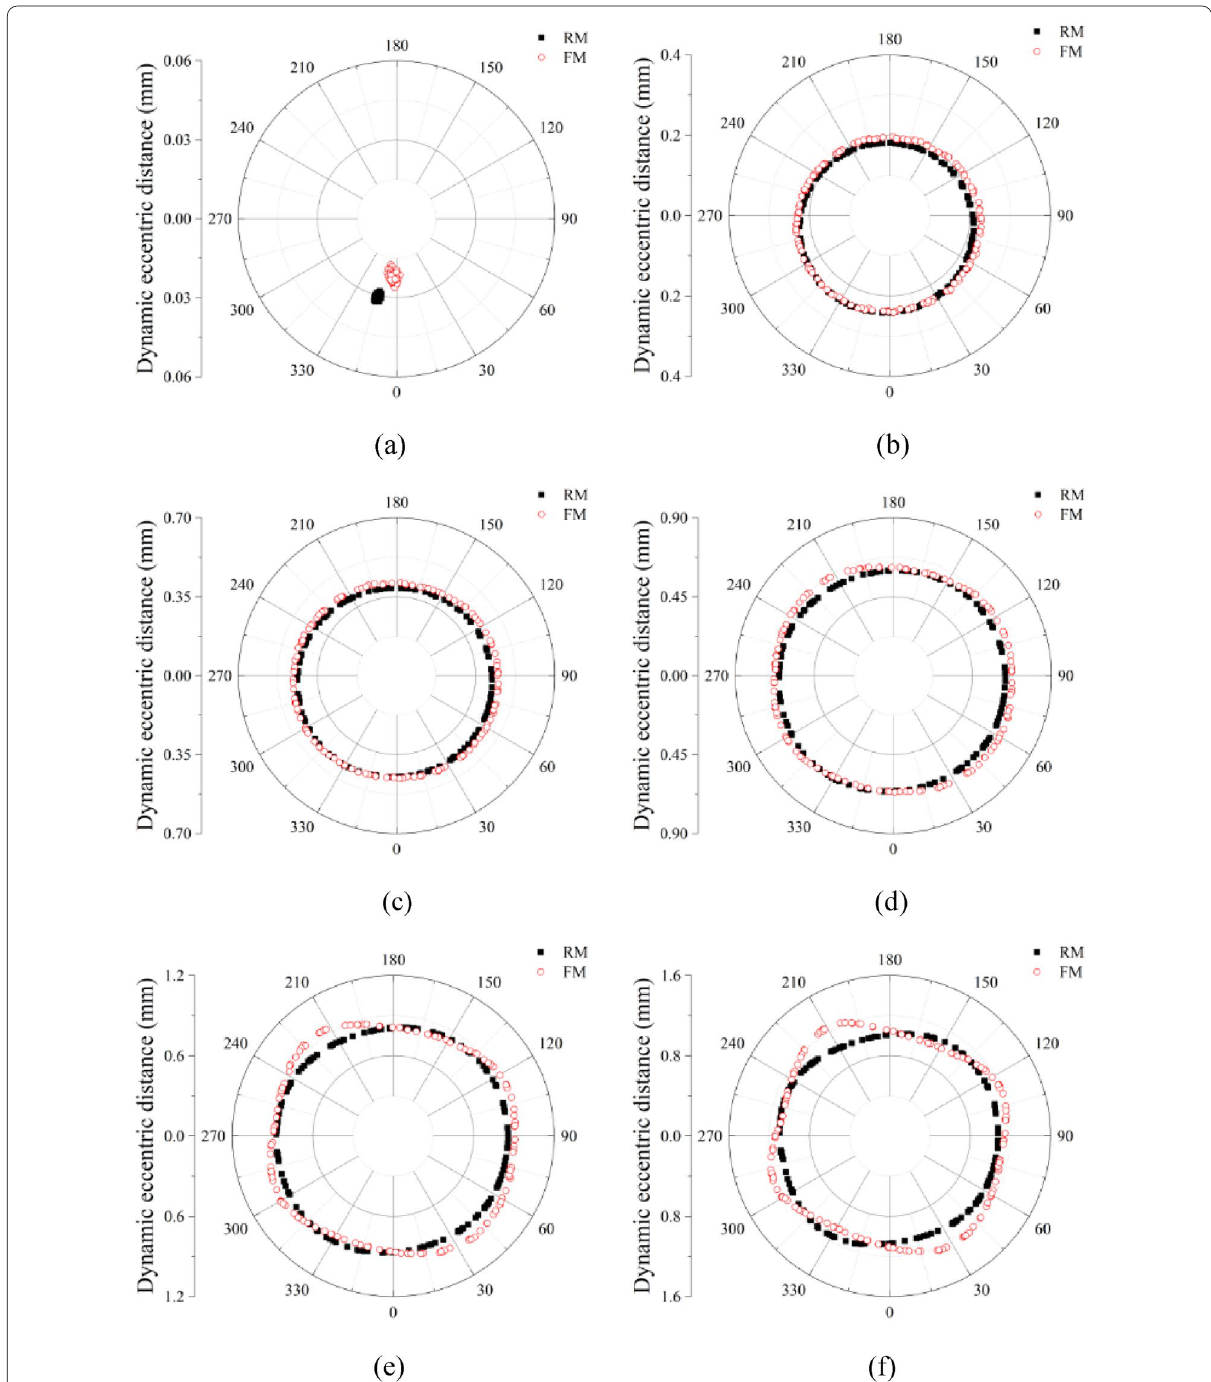
Figure 13 Effect of rotor eccentricity on range of rotor motion: a 0 mm, b 0.2 mm, c 0.4 mm, d 0.6 mm, e 0.8 mm, and f 1.0